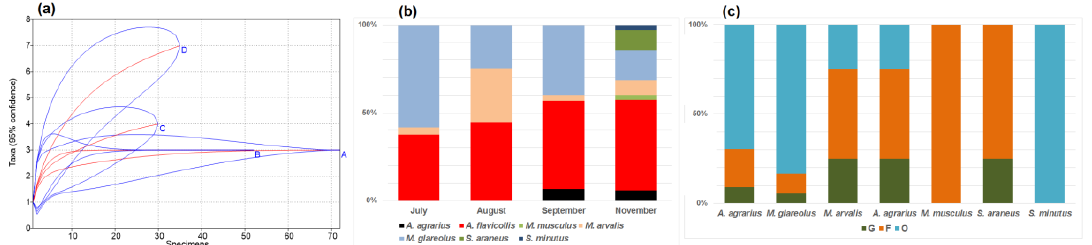
Figure 2. Small mammal species accumulation curves ( a ): A—July, B—August, C—September, D—November, seasonal species share ( b ), and composition by habitats in autumn ( c ): G—garden habitats, F—buildings where food for animals is available, O—outbuildings, not related to food